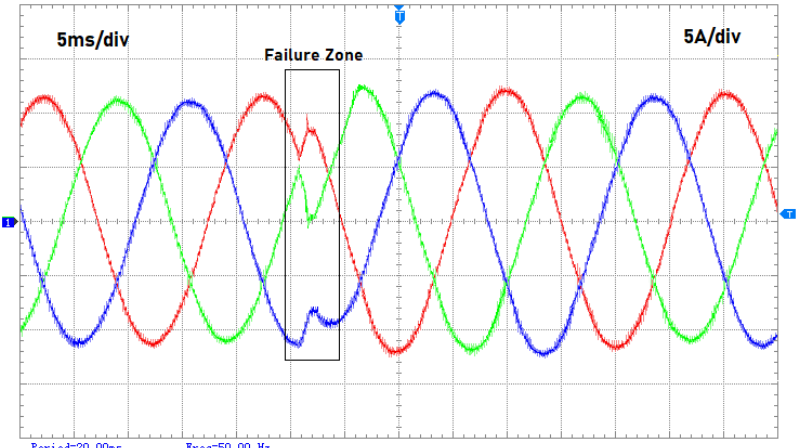
Figure 7. Experimental inverter three-phase currents for an intermittent fault in transistor T 1U in which the start of the fault is not at the beginning of the semicycle.